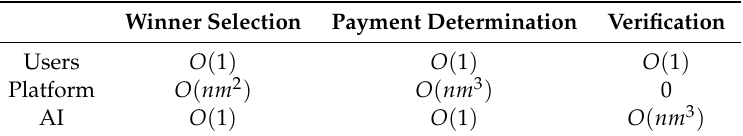
Table 3. Computation overhead of